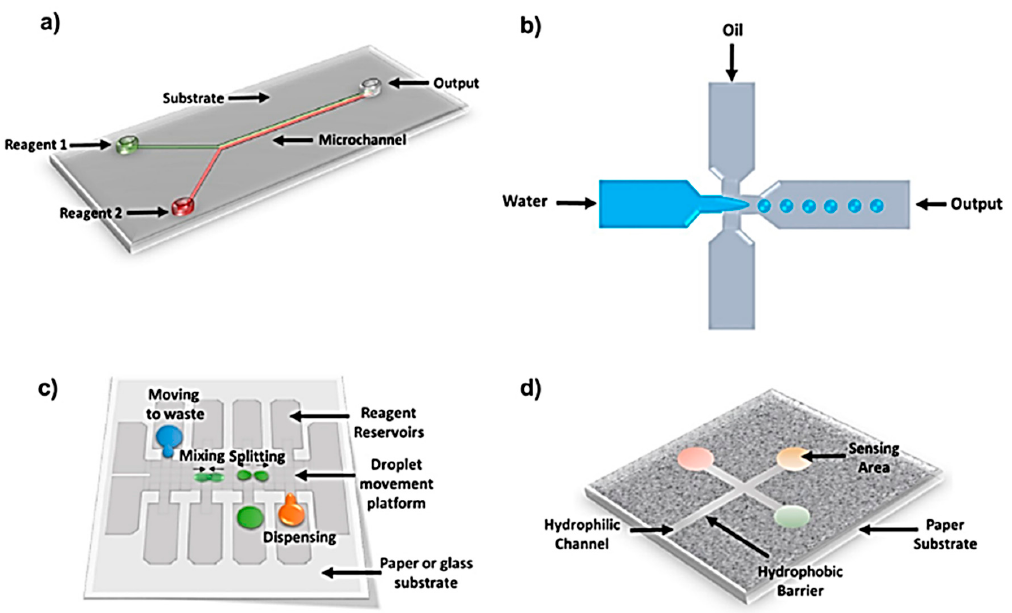
Figure 1. Schematics showing different types of microfluidic platforms: ( a ) Polydimethylsiloxane (PDMS) based microchannels showing a continuous flow channel microfluidic platform. ( b ) Droplet microfluidic system to create immiscible liquid droplets working as micro ‐ reactors. ( c ) Digital